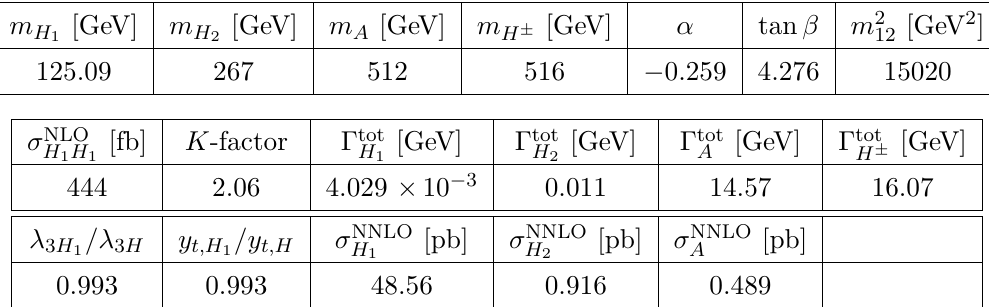
Table 8 . BP1 Upper: R2HDM-1 input parameters. Lower: NLO QCD H 1 H 1 pair production cross section in gluon fusion in the heavy loop particle limit, K -factor, the total widths of the Higgs bosons, the SM-like ( H ) Yukawa and trilinear Higgs couplings normalized to their SM values and 1 the single Higgs production cross sections at NNLO QCD for H and A 1 , 2